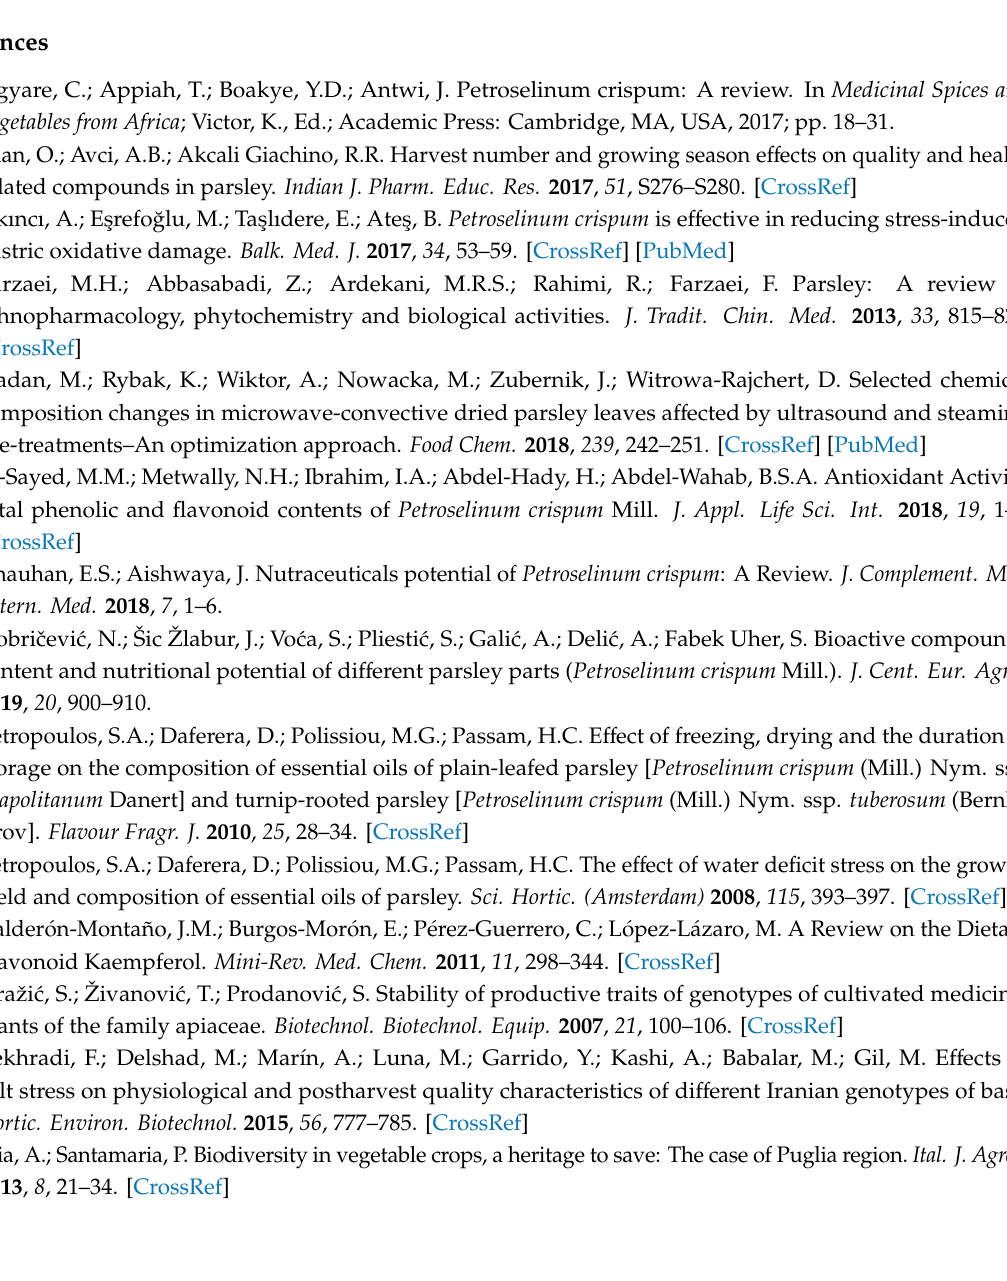
Table S1: Fatty acids composition (%) of the studied parsley leaves samples (mean ±